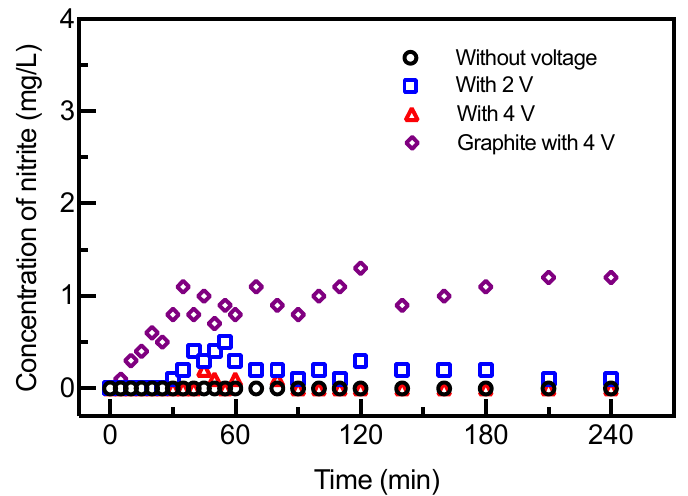
Figure 5. Accumulation of nitrite during nitrate removal by biochar electrode. [NO 3 − ] 0 = 100 mg/L, V = 600 mL, and T = 25 °C.